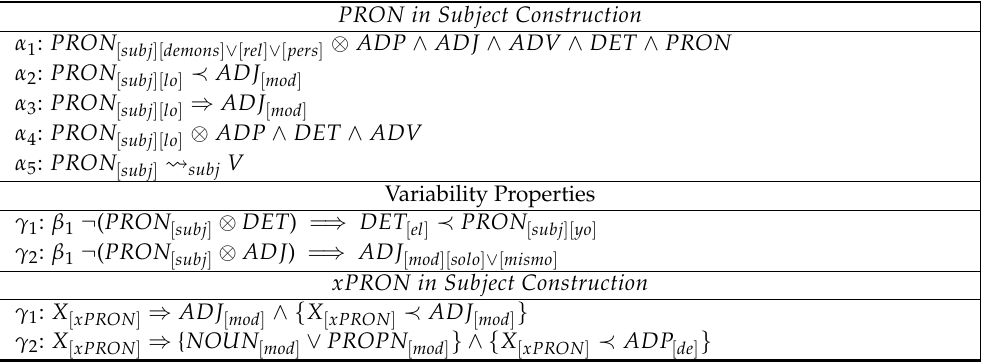
Table A6. Spanish properties of PRON .